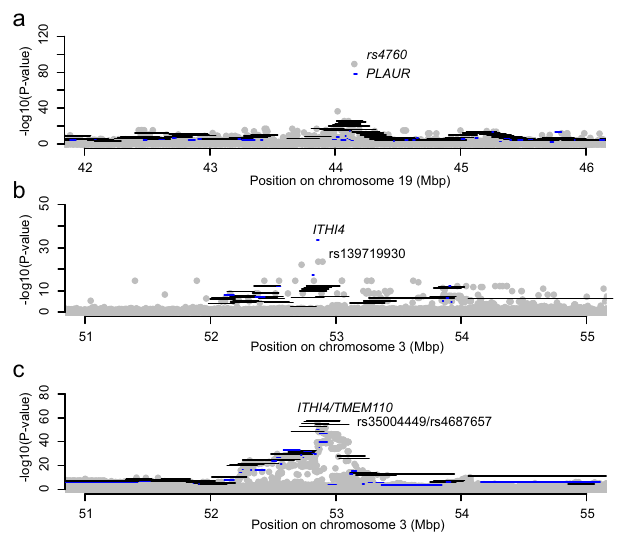
Fig. 5 Regional plots for three proteins. The grey circles are the – log10 p -values (Wald-test) from the GWAS. Horizontal lines indicate the – log10 p -values (SKAT-test) for the Trans -Flank-sets in black and Trans -CDS-sets in blue. As can be clearly seen, multiple, partly overlapping Trans -Flank-sets have been analysed. a Results for TNFRSF10C levels, b VWC2 levels, and c NEP number of SNVs to be tested in each multivariable model, only